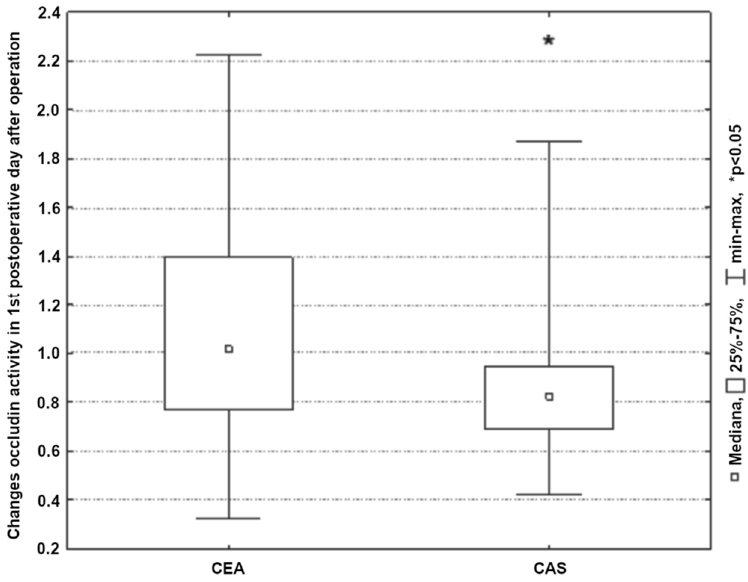
Figure 7. Changes occludin activity in 1st postoperative day after CEA/CAS procedure.